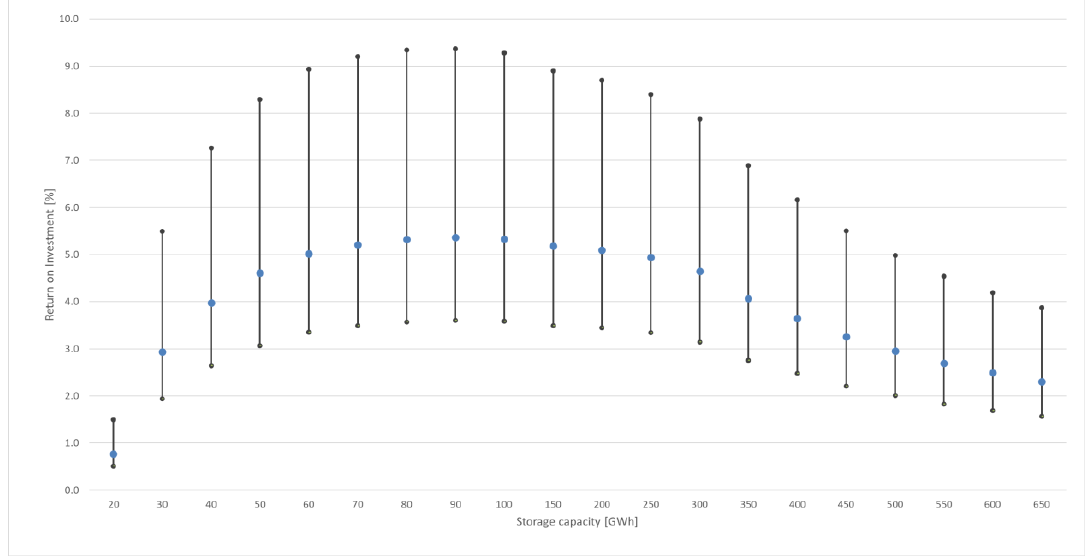
Figure 3. Return on investment of seasonal storages with 200 MW power.